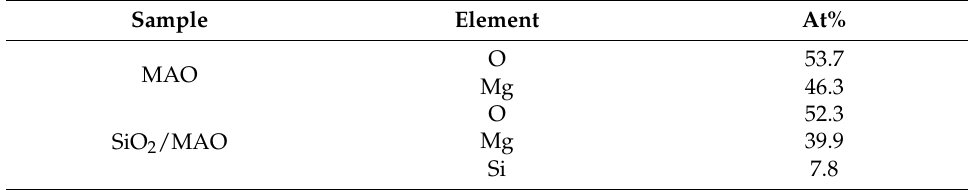
Table 3. Weight percentage and atomic percentage of the surface elements of two coatings.